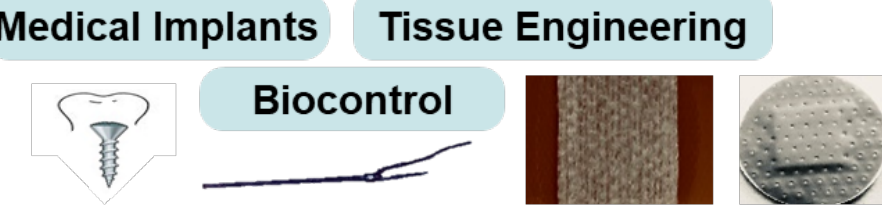
Figure 1. Biomedical applications of polyhydroxyalkanoates.